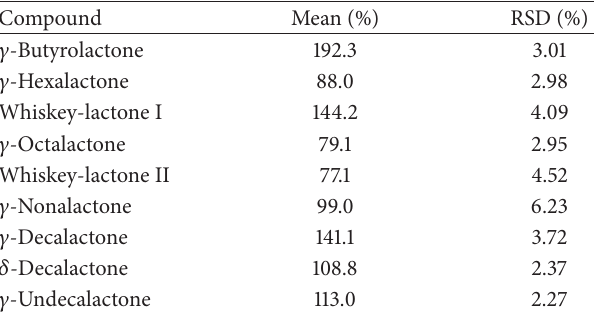
Experimental section. Results are shown in Table 7. 𝛾 -Nonalactone and 𝛿 -decalactone are free from matrix effect showing recoveries in the range of 100 ± 10%. The most affected compounds are 𝛾 -butyrolactone, whiskey-lactone I, and 𝛾 -decalactone. Matrix effect was revealed to be similar for white and red